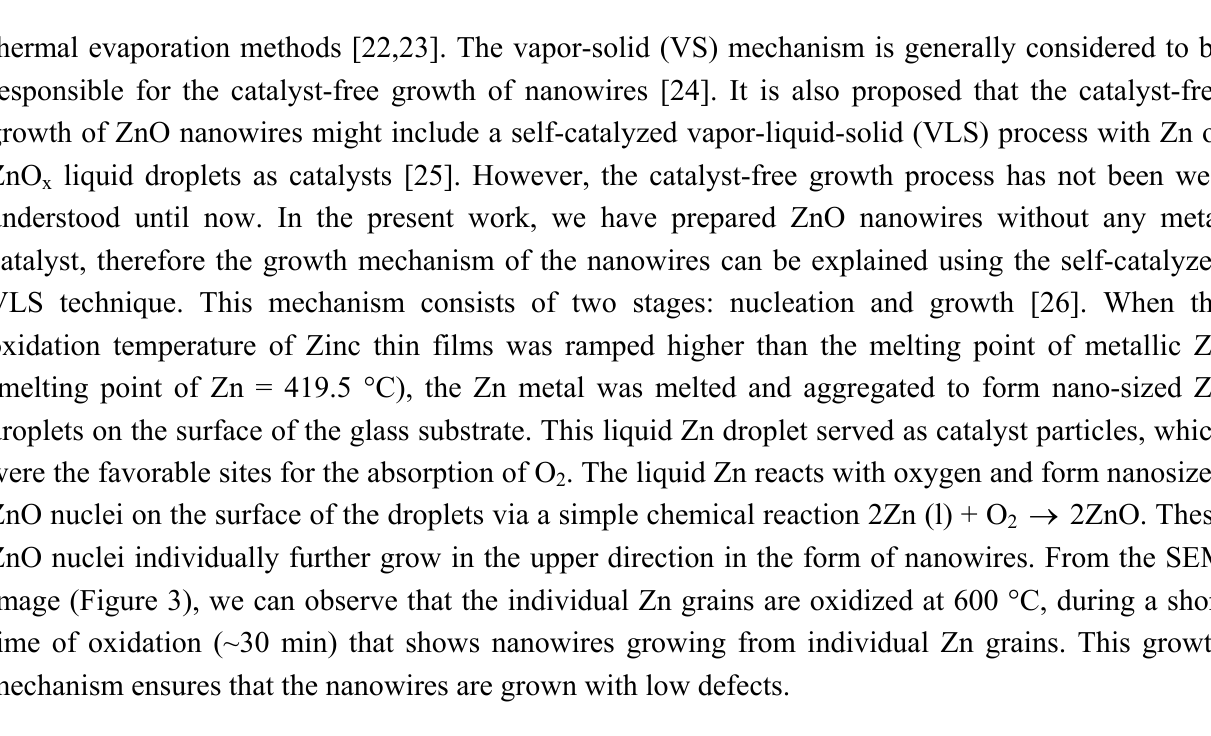
Figure 3. SEM image for showing nanowires growing from individual Zn grains (thin film was oxidized at 600 °C for 30 min in